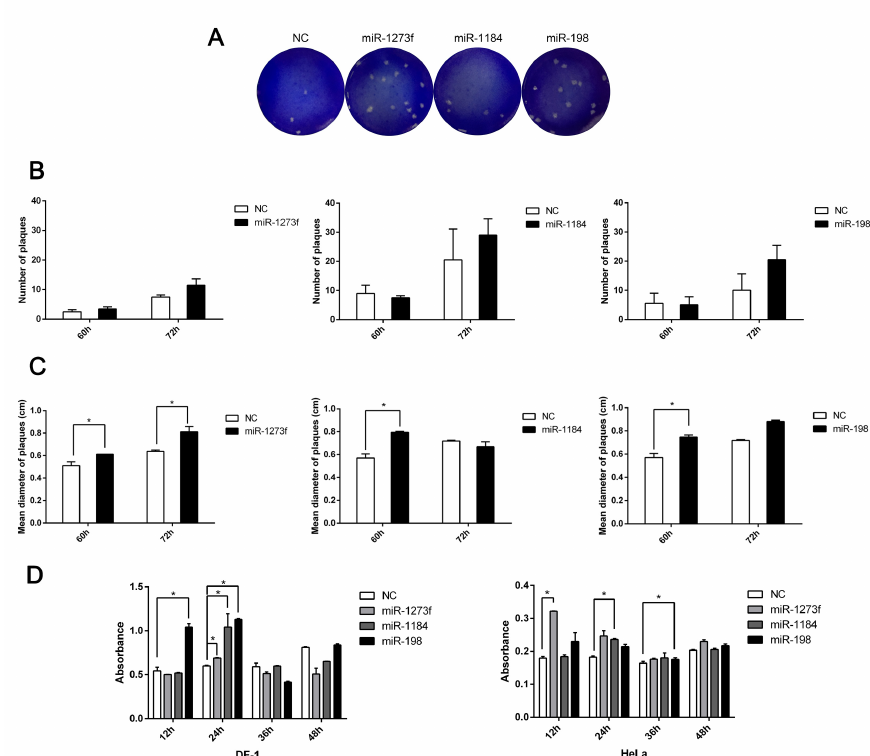
Figure 7. Exosomes carrying miRNAs promote NDV spread. ( A ) NDV titers were detected by plaque assay in DF-1 cells transfected with miRNA mimics and then infected with NDV. ( B ) The average number of plaques was calculated in DF-1 cells transfected with miRNA mimics and then infected with NDV by the Image-Pro Plus 6.0 software. ( C ) The mean diameter of plaques in ( B ) was measured in DF-1 cells transfected with miRNA mimics and then infected with NDV by the Image-Pro Plus 6.0 software. ( D ) Absorbance was detected by ELISA in DF-1 cells and HeLa cells were transfected with miRNA mimics and then infected with NDV. Error bars are the SEM from three independent experiments. Statistical significance is indicated: ** p < 0.01 and * p <